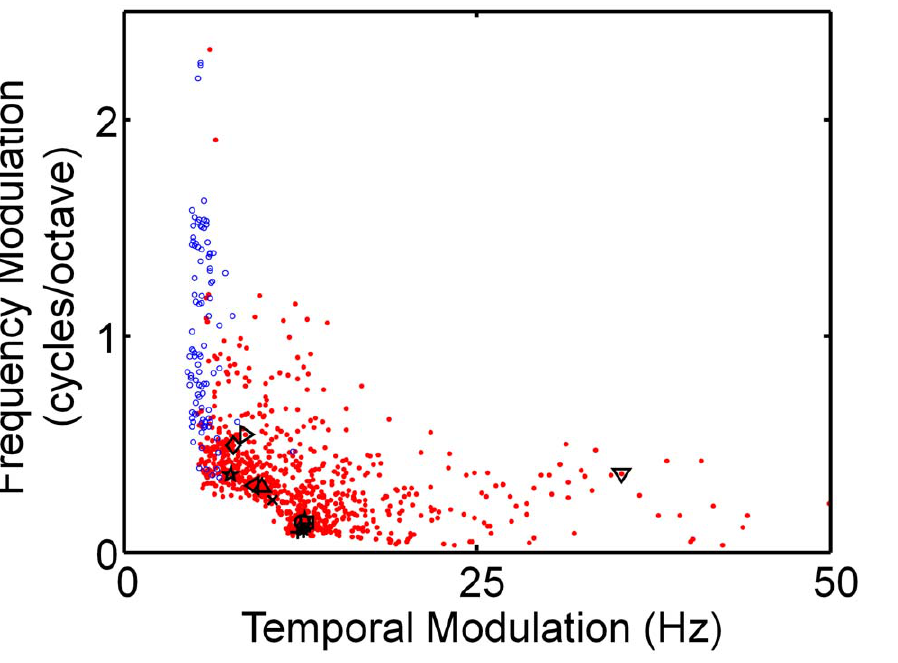
Figure 5. Our overcomplete, spectrogram-trained model exhibits similar spectrotemporal tradeoff as Inferior Coliculus. Modulation spectra of half-complete cochleogram-trained dictionary and four-times overcomplete spectroram-trained dictionary are shown. The four-times overcomplete spectrogram-trained dictionary elements (red dots; same dictionary as in Fig. 4 ) display a clear tradeoff between spectral and temporal modulations, similar to what has been reported for Inferior Colliculus (IC) [30]. By contrast, the half-complete cochleogram-trained dictionary (blue circles; same dictionary as in Fig. 2 ) exhibits a much more limited range of temporal modulations, with no such tradeoff in spectrotemporal resolution. Each data point represents the centroid of the modulation spectrum of the corresponding element. The elements shown in Fig. 4 are indicated on the graph with the same symbols as before. suppression follows excitation as shown in two cat IC STRFs ( Fig. 6c ) with matching examples from our model dictionaries ( Fig. 6d ). Note that the experimental receptive fields extend to higher frequencies because the studies were done in cats and gerbils, which are sensitive to higher frequencies than we were probing with our human speech training set. The difference in time-scales between our spectrogram representation and the experimental STRFs could reflect the different timescales of speech and behaviorally relevant sounds for cats and rodents. A common feature of thalamic and midbrain neural receptive fields is a localized checkerboard pattern of excitation and suppression ( Fig. 7 ), typically containing between four to nine distinct subfields. We present experimental gerbil IC, cat IC and cat MGBv STRFs of this type in Fig. 7a beside similar examples from our model ( Fig. 7b ). This pattern is displayed by many elements in our sparse coding dictionaries, but to our knowledge it has not been predicted by previous theories. We also find some less localized receptive fields that strongly resemble experimental data. Some model neurons ( Fig. 8b ) consist of a suppression/excitation pattern that extends across most frequencies, reminiscent of broadband OFF and ON responses as reported in cat IC and rat A1 ( Fig. 8a ). Another shape seen in experimental STRFs of bat IC (top), and cat A1 (bottom; Fig. 8c ) is a diagonal pattern of excitation flanked by suppression at the higher frequencies. This pattern of excitation flanked by suppression is present in our dictionaries ( Fig. 8d ), including at the highest frequencies probed. This type of STRF pattern is reminiscent of the two-dimentional Gabor-like patches seen in V1, which have been well captured by sparse coding models of natural scenes [10,11,26].